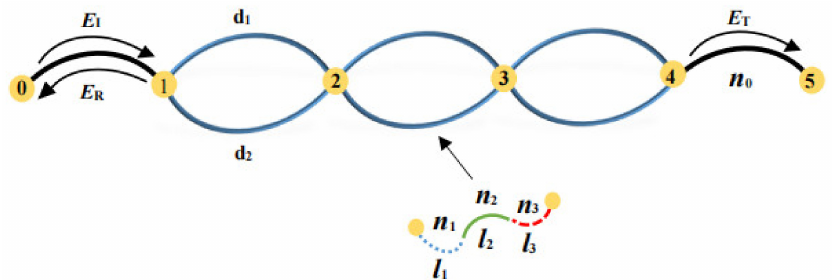
Figure 1. Schematic diagram of the 1D PTSPROWN with one entrance, one exit, and 3 unit-cells, where E I , E R , and E T are the input, reflective, and output electromagnetic waves, respectively. The thick black solid lines at the entrance and outlet are the vacuum optical waveguide, and their length is d. The thick blue solid lines in the unit-cell made up of three sub-waveguides is a PT-symmetric waveguide, and the length of the waveguides is d 1 and d 2 . The refractive indices of the three sub-waveguides are, respectively, n 1 , n 2 , and n 3 , and their length ratios are l 1 , l 2 , and l 3 ,